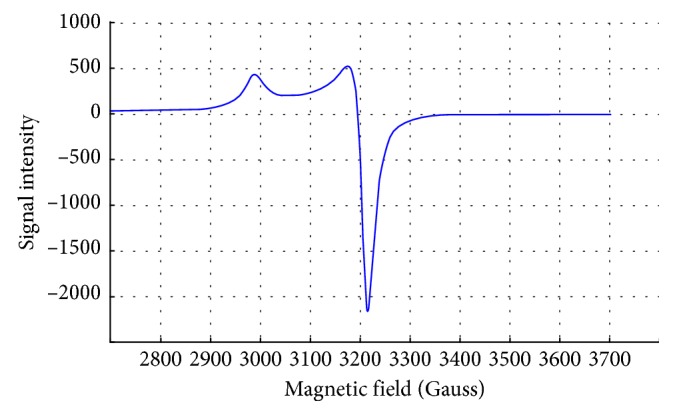
ESR spectrum of L1 + VO(II)complex.